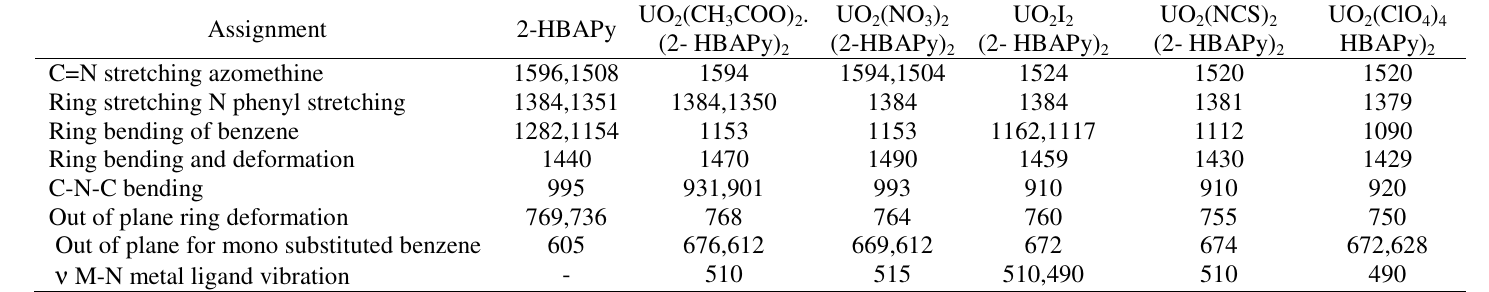
Table 7. Infra red absorpton frequencies (cm -1 ) for dioxouranium(VI) complexes of 2-HBAPy.